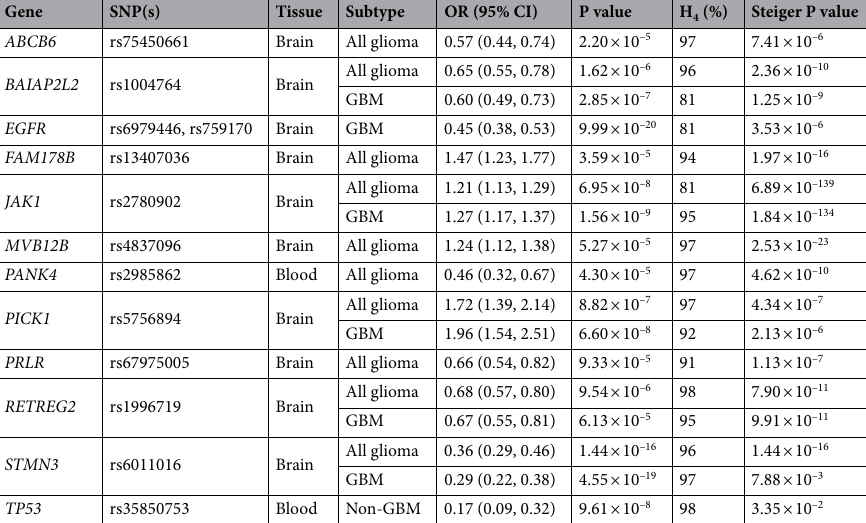
Table 1. Main associations which showed robust evidence from the Mendelian randomisation, colocalisation and Steiger filtering analyses. The colocalisation result for a single, shared causal variant between the gene and all glioma is provided (“H 4 (%)”, see “Methods” section). Steiger filtering showed the correct orientation for the direction of effect between gene expression and subtype risk for all results in this